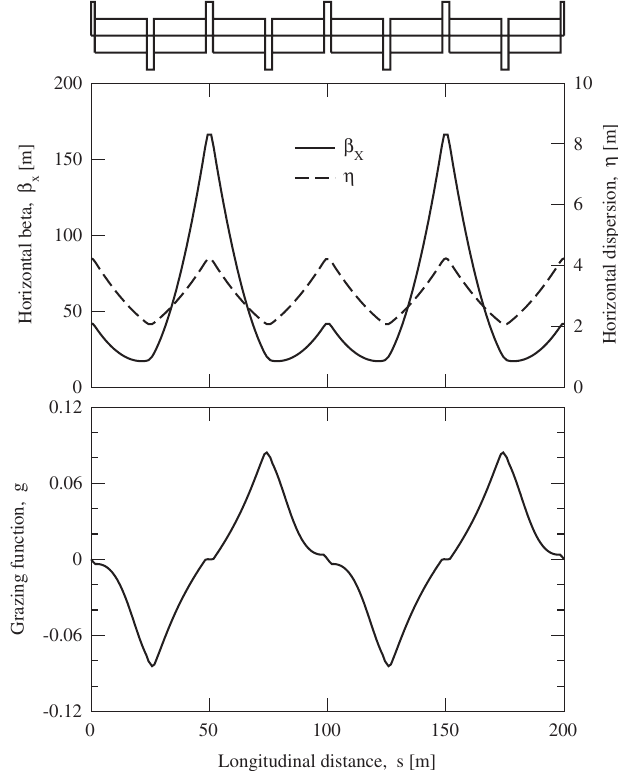
FIG. 4. The grazing function in the presence of a ‘‘100%’’ beta wave, dominated by the 2 (cid:4) harmonic and modulated by 1 = The maximum g value of 0.084 is in only fair agreement with the thin quadrupole prediction of 0.139, due to the breakdown of first order perturbation theory with such large